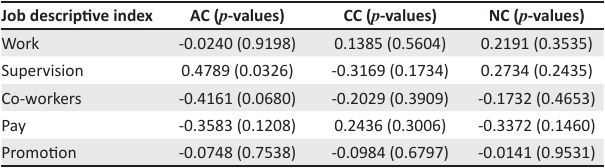
TABLE 8: Pearson’s correlation coefficients and associated p -values between the JDI and the OCQ instruments. Job descriptive